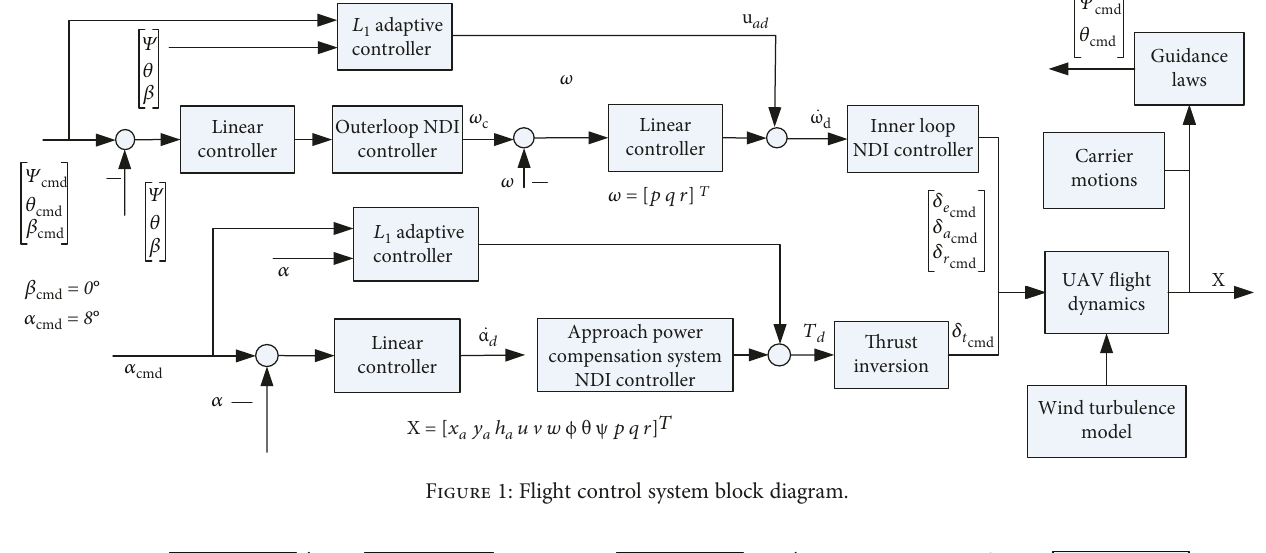
Figure 1: Flight control system block diagram.